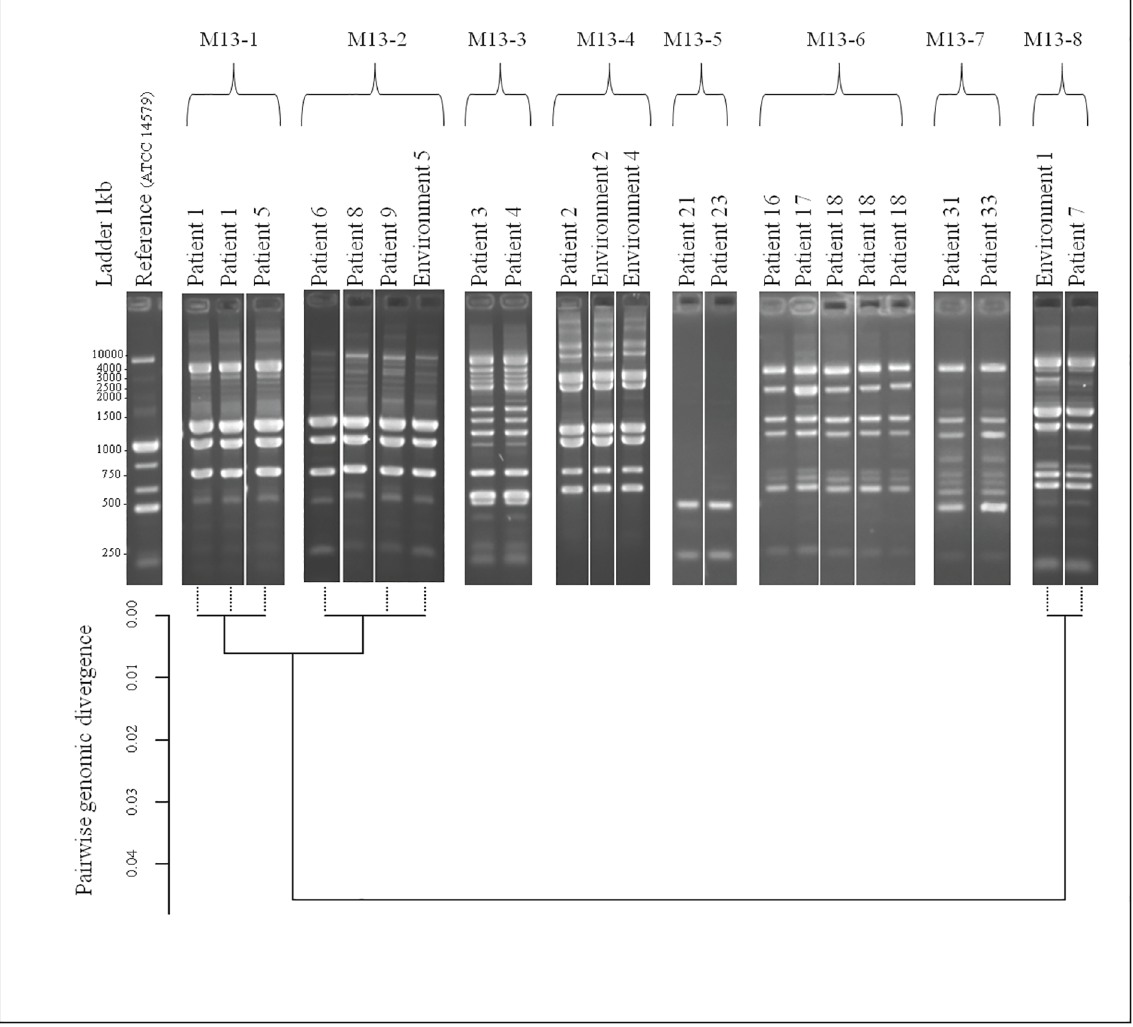
Fig 4. M13-PCR fingerprint patterns of B . cereus strains showing eight possible cross contaminations between patients/patients or patients/environment. Top panel, lane 1: 1kb DNA ladder. Lane 2: reference strain B . cereus ATCC14579. Lane 2 to 23: B . cereus strains. Bottom: divergence tree between eight samples obtained by hierarchical clustering based on the matrix of pairwise divergences after WGS data.